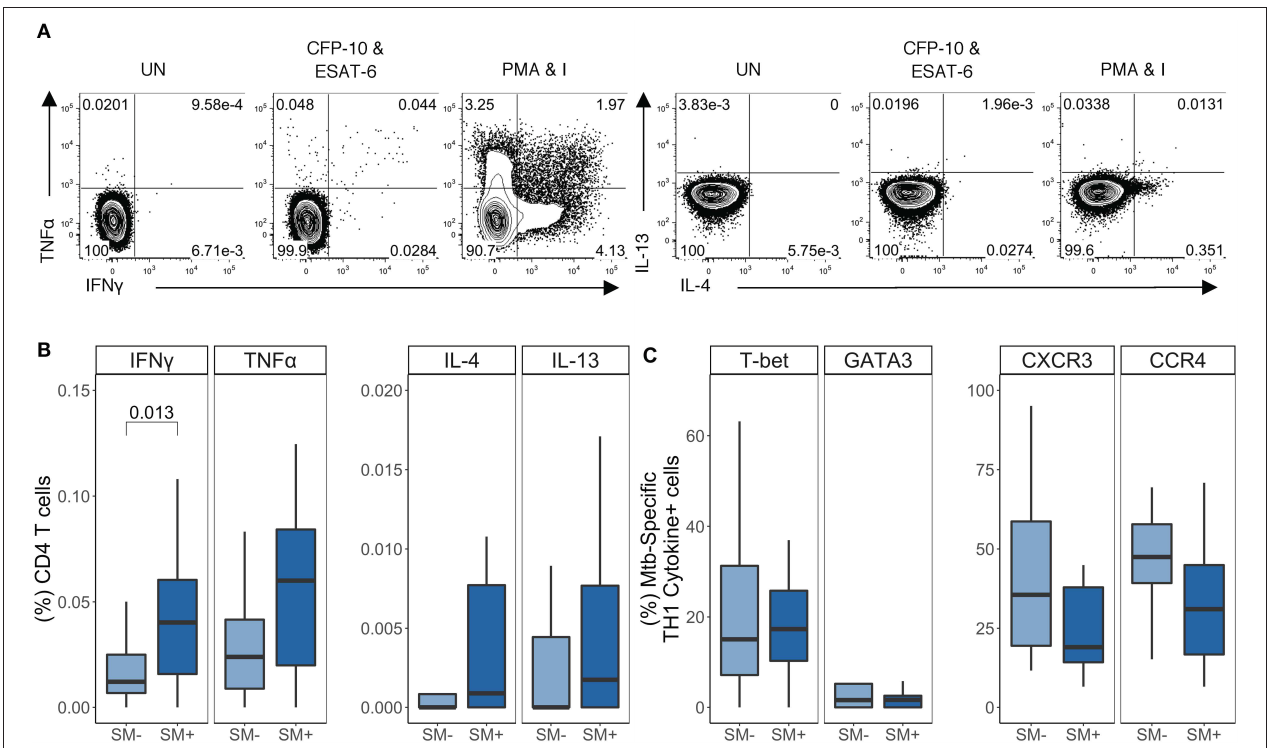
FIGURE 4 | SM + LTBI individuals have higher frequencies of TH1 cytokine + Mtb-specific CD4T cells, which express both TH1 and TH2 lineage markers. PBMC samples obtained from SM + and SM − LTBI individuals were incubated for 18h in media alone (negative control), PMA and ionomycin (positive control), or CFP-10 and ESAT-6 peptide pools. Intracellular expression of IFN- γ , TNF- α , IL-4, and IL-13 was measured by flow cytometry. (A) Representative flow cytometry data from an SM + individual. Plots are shown gated on live CD3 + CD4 + CD8 − lymphocytes from the unstimulated and stimulated conditions. (B) Frequency of each subset of TH1 cytokine + and TH2 cytokine + CD4T cells (SM − , n = 24; SM + , n = 22). Data are shown after subtraction of background cytokine production in the unstimulated negative control condition. (C) Samples meeting the criteria for a positive TH1 cytokine response (see Materials and Methods) were evaluated for expression of lineage specific transcription factors and chemokine receptors by flow cytometry. The frequency of indicated transcription factor + and chemokine receptor + TH1 cytokine + CD4T cells are reported (SM − , n = 16; SM + , n = 18). Boxes represent the median and interquartile ranges; whiskers represent the 1.5*IQR. Differences in the frequency of each CD4T cell population between SM + and SM − individuals were assessed using a Mann Whitney U